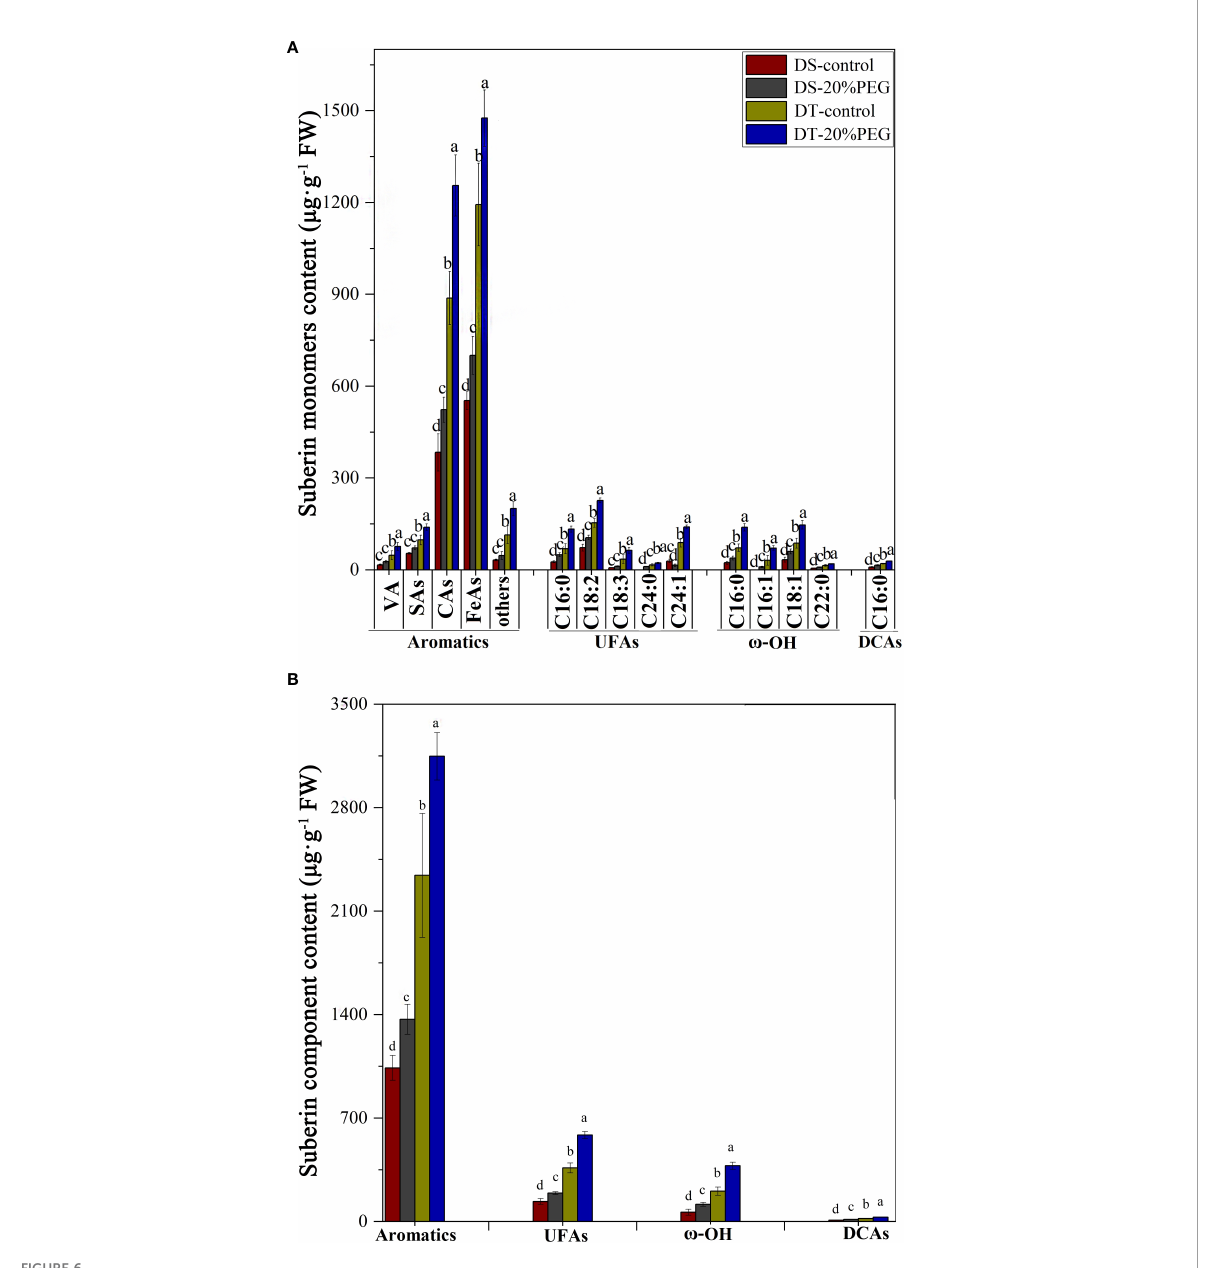
FIGURE 6 Amount of suberin in roots detected in drought-tolerant (DT) and drought-sensitive (DS) genotypes grown under control or osmotic stress conditions. (A) Amount of all detected monomers of suberin in roots. The substance classes of aromatic components include vanillin (VA), salicylic acids (SAs), coumaric acids (CAs), ferulic acids (FeAs), and others; the substance classes of aliphatic components included unsubstituted fatty acids (UFAs), w -hydroxy acids ( w -OH), and a , w -dicarboxylic acids (DCAs). (B) Amounts of major substance classes of suberin. Absolute amounts of suberin are shown as mean values in m g·g − 1 fresh weight (FW) ± the standard deviation (SD) of four biological replicates (n = 4). Different letters indicate signi fi cant differences at P < 0.05 based on one-way analysis of variance (ANOVA) (Fisher ’ s Duncan